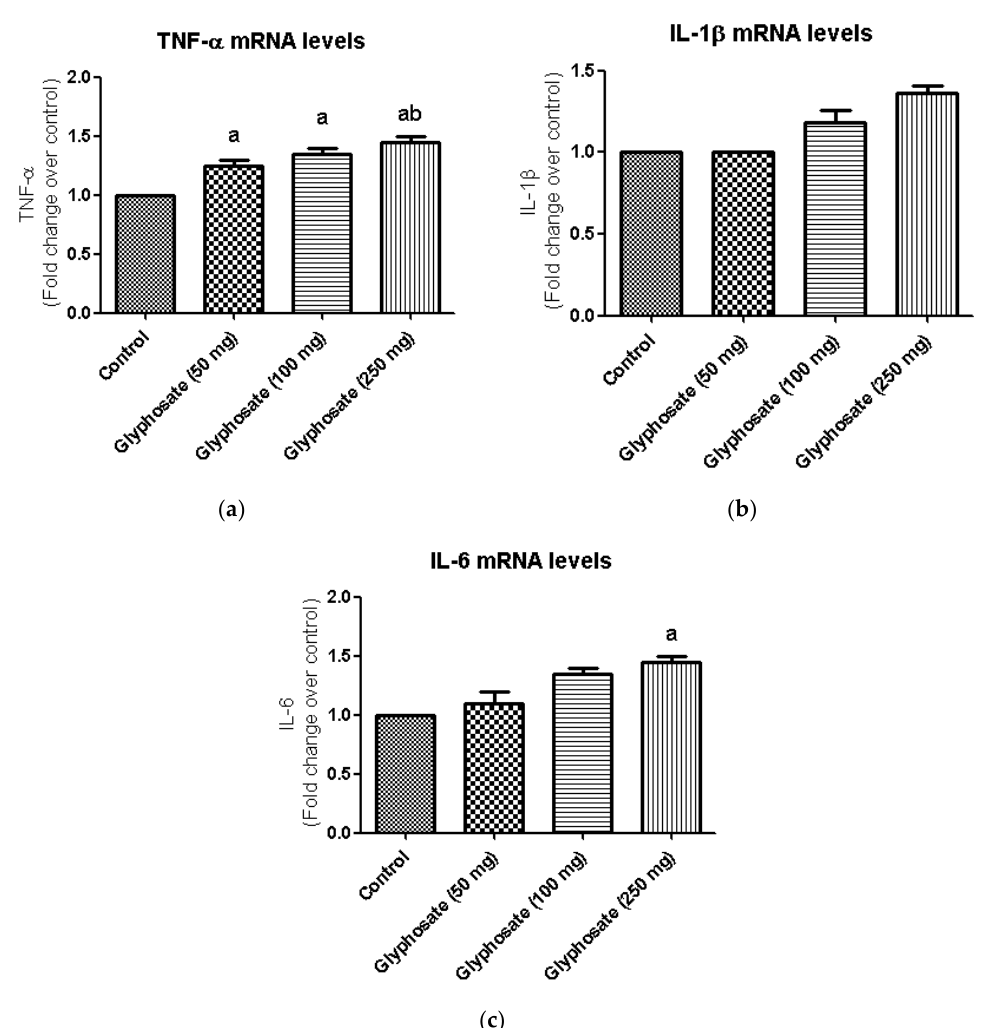
Figure 8. ( a – c ): The effect of glyphosate on mRNA levels of pro-inflammatory cytokines (TNF- α, IL-1 β , and IL-6) in control and glyphosate treated rats. TNF- α , IL-1 β , and IL-6 mRNA expression were analyzed by Real Time-PCR using gene specific primers and results were expression in fold-change over control. Data were expressed as mean ± SEM where n = 6 rats for each group. Values significant at p < 0.05 were analyzed with a — control, b — glyphosate (50 mg/kg b.wt.).